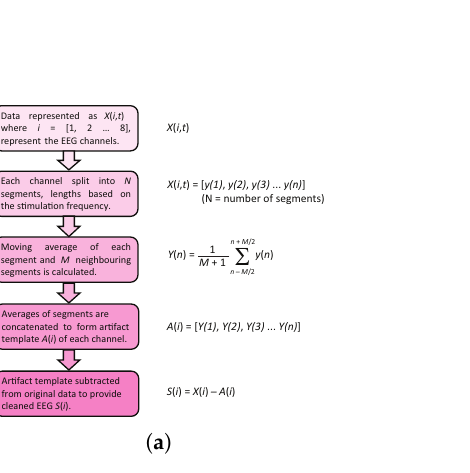
Figure 3. Artifact removal algorithms. ( a ) Superposition of Moving Averages (SMA): A time localized artifact template is generated for each channel and subtracted from the recorded data. Figure originally reported in [12] (with copyright permission from IEEE). ( b ) Adaptive Filtering (AF): A recorded version of the tACS output is used to dynamically set the artifact removal filter